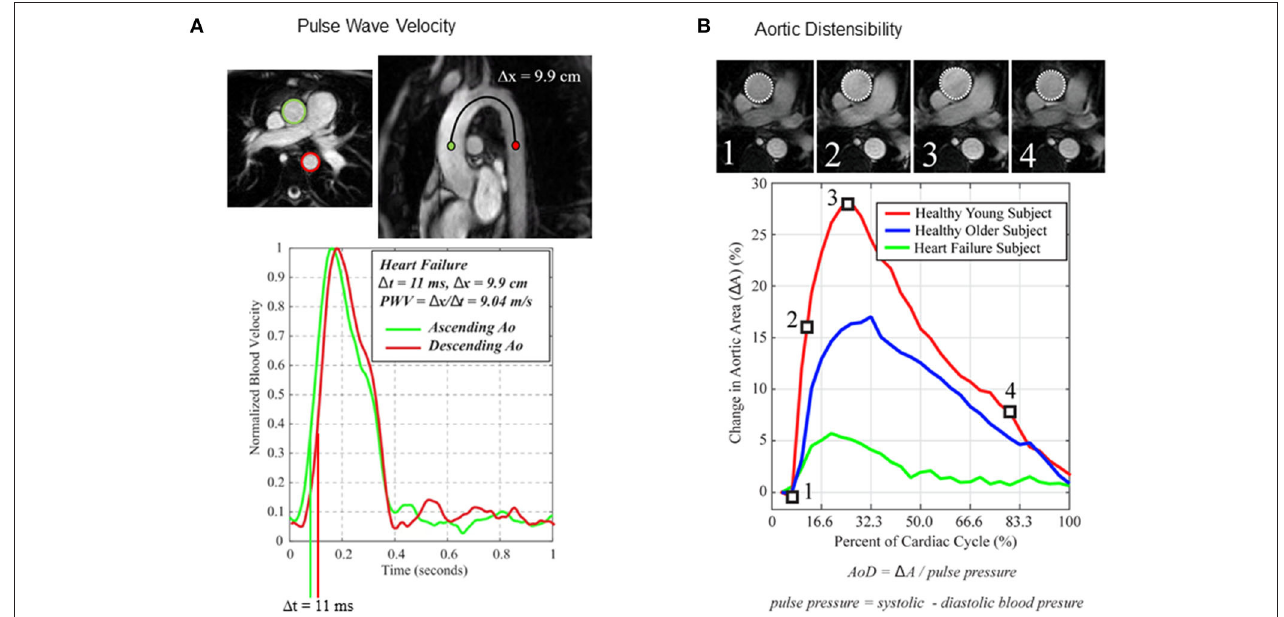
FIGURE 3 | Imaging techniques used to assess the effects of exercise training in patients with or at risk for cardiovascular disease. (A) MRI derived arterial stiffness. Pulse wave velocity (PWV) estimated from MRI derived phase velocity imaging of the thoracic aorta in an older patient with heart failure. Adapted from Thompson et al. (101). (B) Thoracic aorta distensibility (AoD) on SSFP cines. Comparison of aortic distensibility between a young healthy individual, an older healthy individual and an older patient with heart